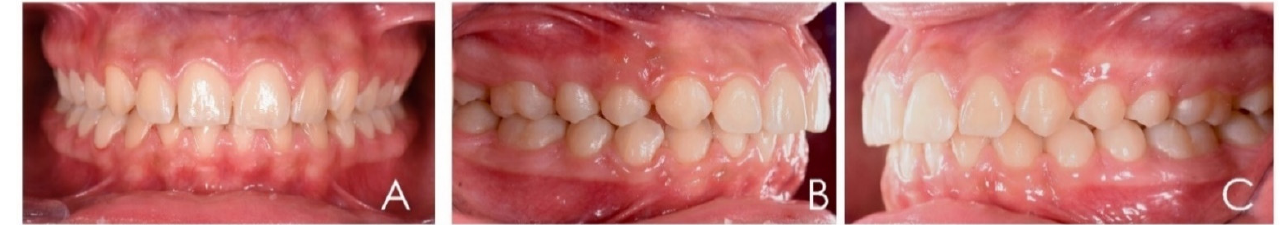
Figure 7. Intraoral photograph with the AMCOP Integral device.